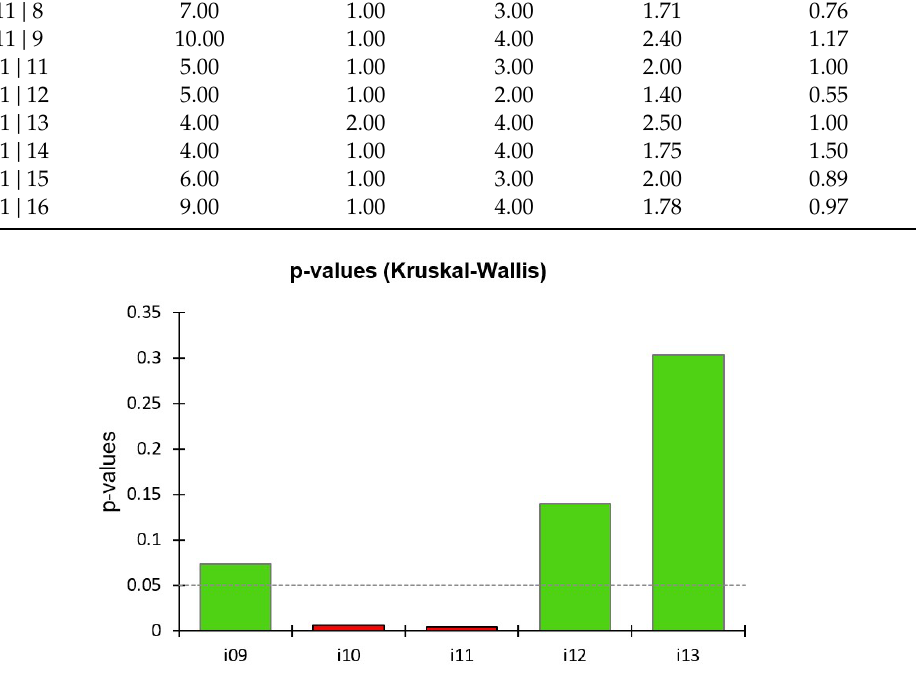
Figure 8. Box plot of the average score of Item 11 (presentation of the contents of the programs) according to whether the program is general or specific.